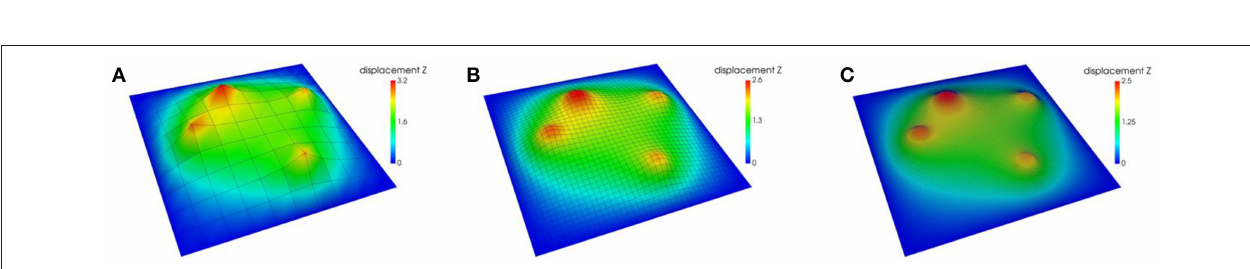
FIGURE 4 | In a computational model with N 2 d el = 100 4-noded membrane finite elements, an initially stress-free elastic rubber membrane is first subjected to an in-plane prestretch by a factor of 1.6 in both directions, then fixed at the boundaries and subjected to out-of-plane loading with circular surface loads (red circles with crosses). Finally, the out-of-plane displacement of the membrane center is recorded in the loaded configuration as output of the computational model. This output forms together with the positions of the four loads a training sample for the ANN with the specific fidelity level corresponding to a discretization with N 2 d el = 100 finite elements.